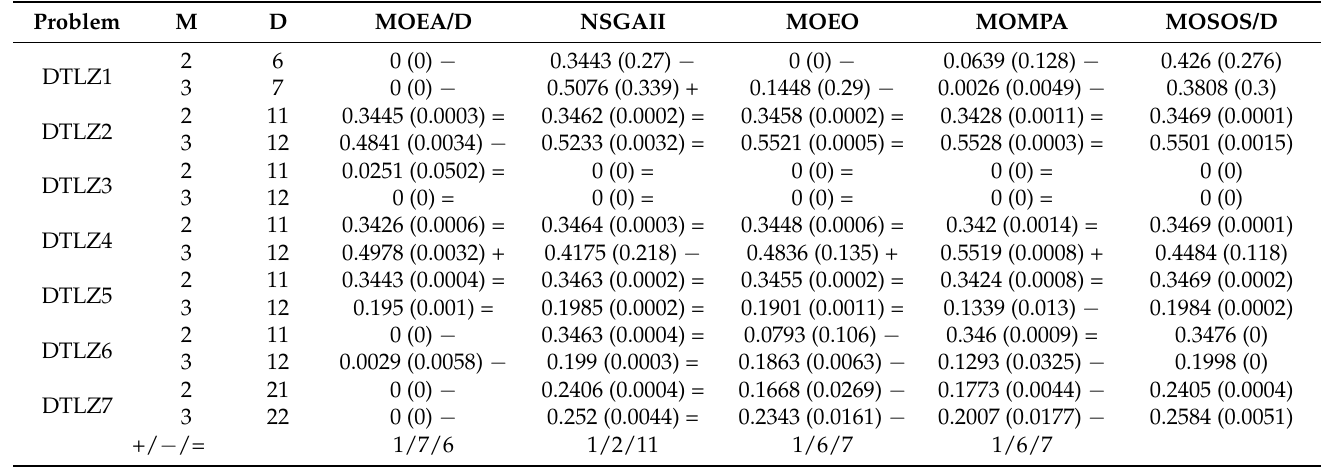
Table 5. The HV (diversity) metric comparison.